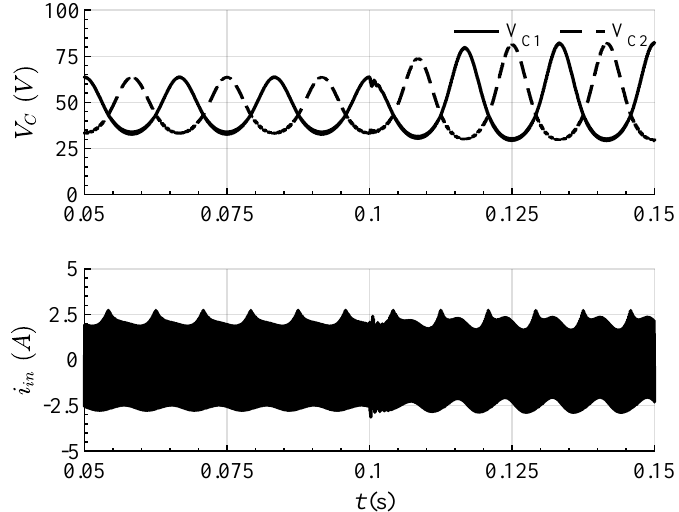
Figure 19. The output capacitor voltages and the supply current due to a step change in